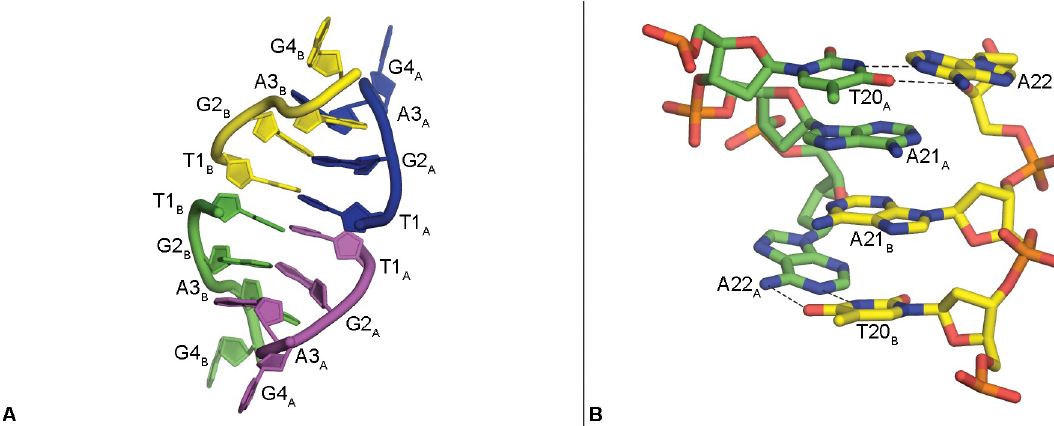
Fig 4. Packing interactions. Quaternary interaction of four 5’-head regions (T1-G2-A3); each color represents a separate symmetry- related strand (A). Stacked helical structure formed between 3’-tail regions of (T20-A21-A22) in the crystal lattice (B).